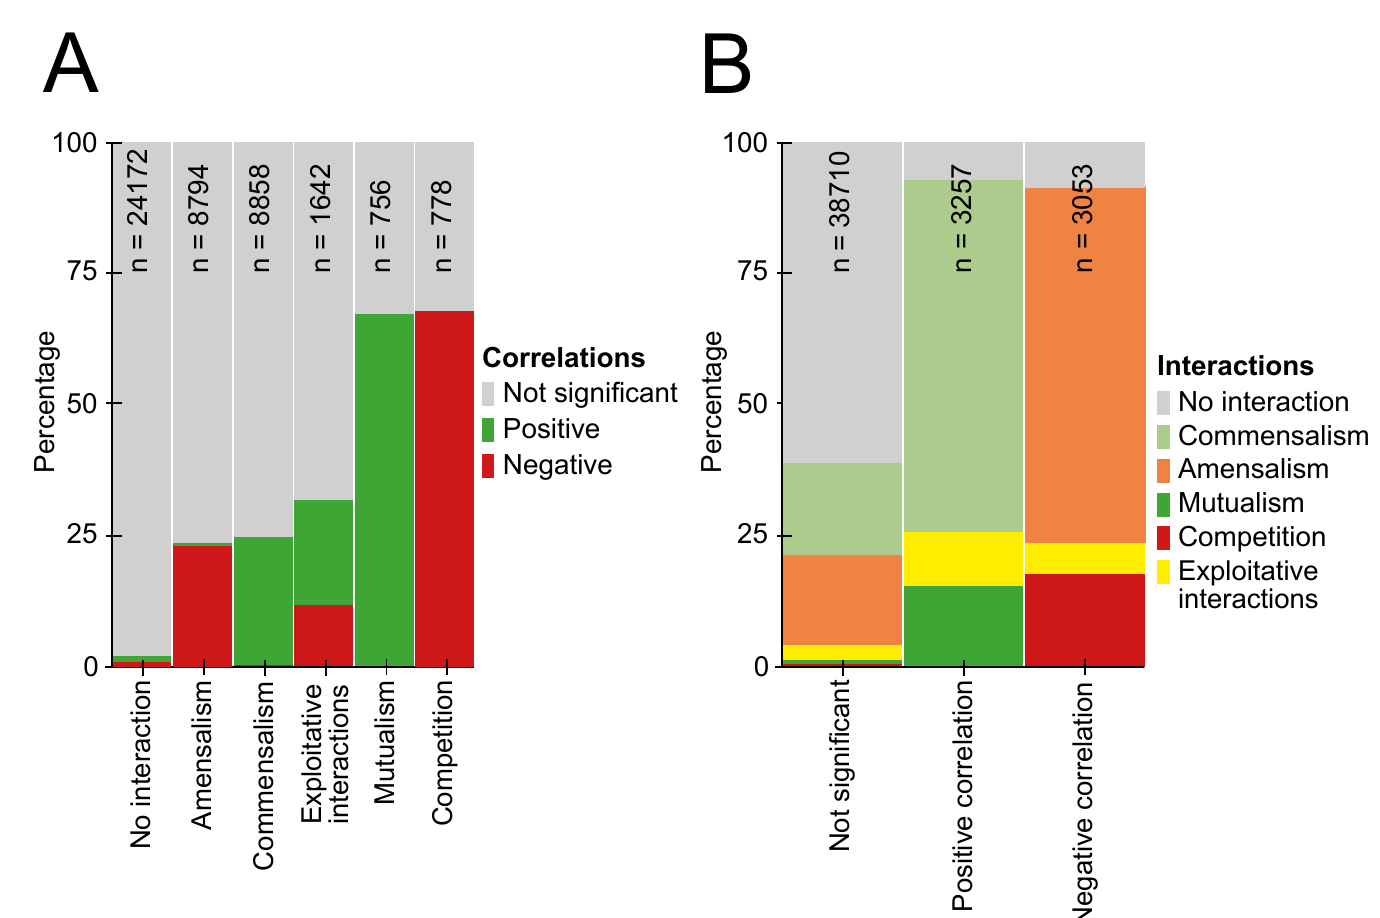
Fig 3. The percentage of significant partial correlations (with sign matching interaction in either direction), as recovered from the base case model. (A) For different types of pairwise interactions and (B) for the different correlations.